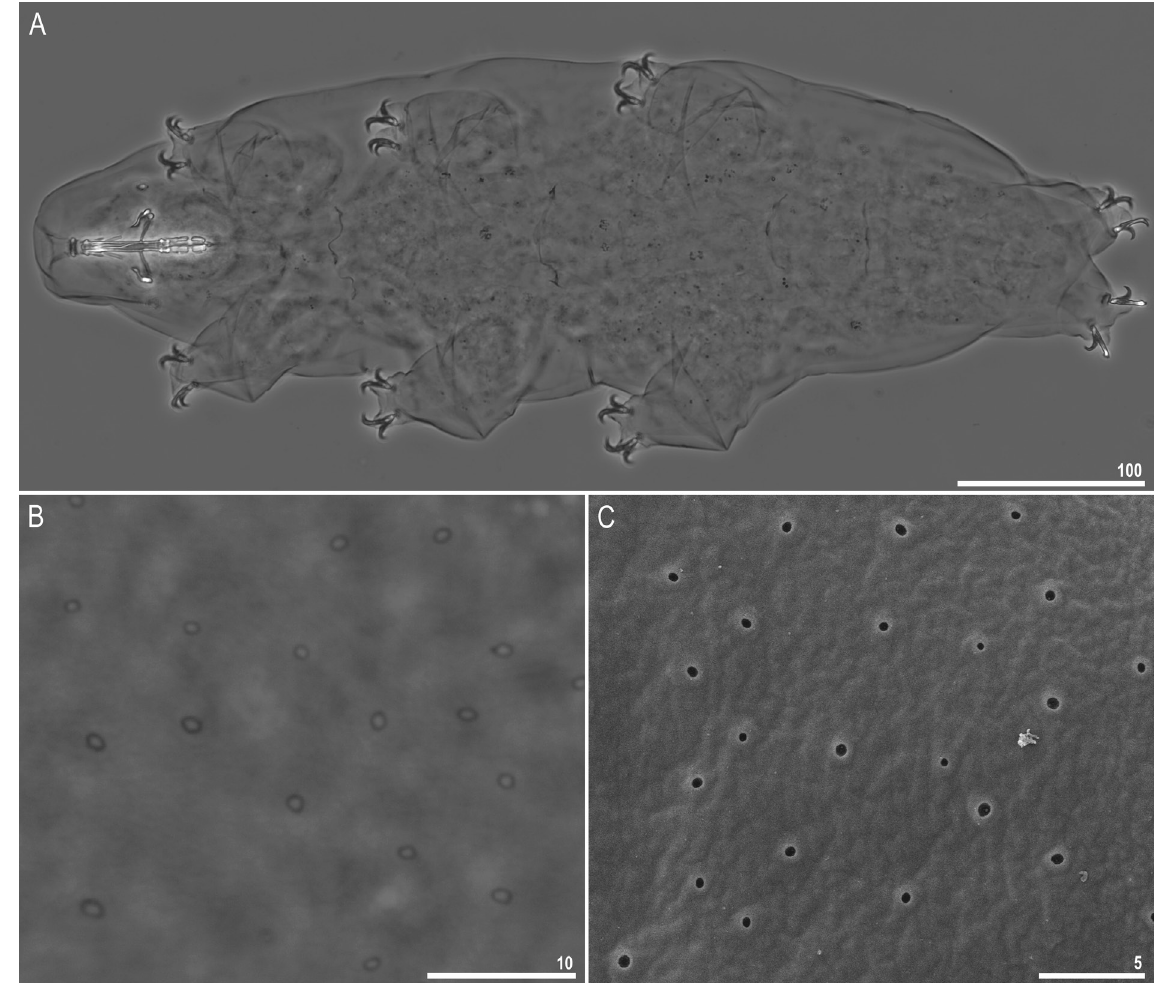
Fig. 8. Macrobiotus kamilae sp. nov., habitus. A . Dorso-ventral projection (holotype, Hoyer’s medium, PCM, IZiBB IN.030.08). B–C . Cuticular pores on the dorsal part of the body seen in PCM (B: holotype) and in SEM (C: paratype, IZiBB). Scale bars in